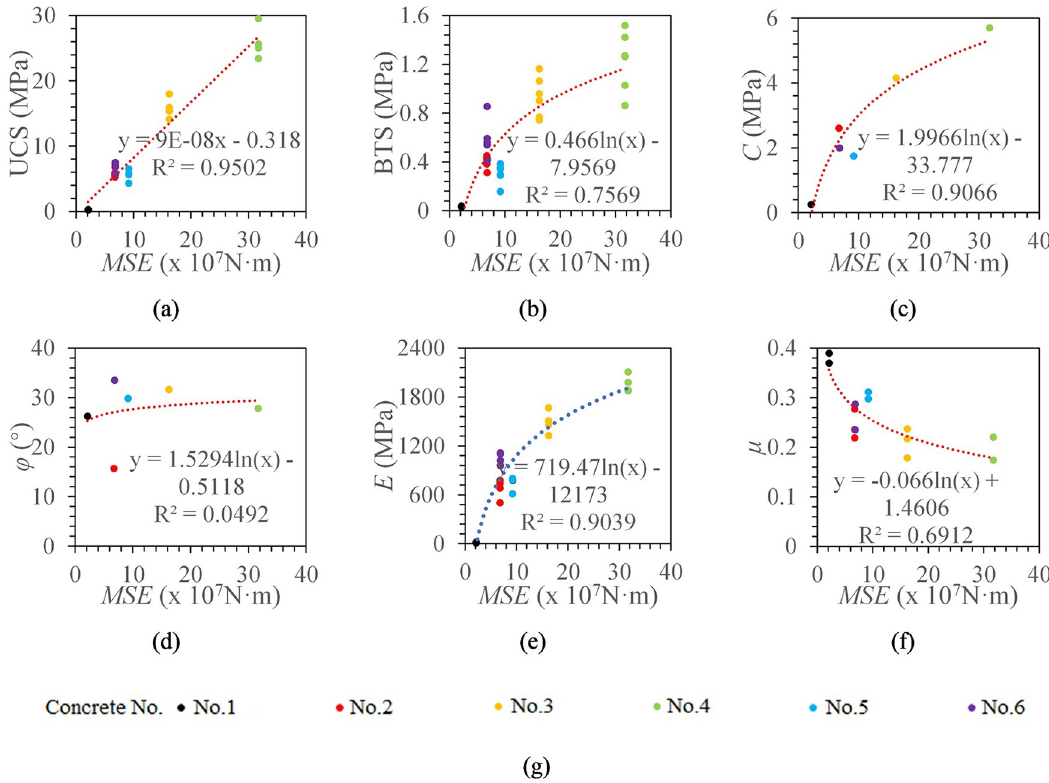
Fig 14. The relationship between MSE and concrete mechanical properties. (a) The relationship between MSE and UCS. (b) The relationship between MSE and BTS. (c) The relationship between MSE and C . (d) The relationship between MSE and φ . (e) The relationship between MSE and E . (f) The relationship between MSE and μ . (g) legend.